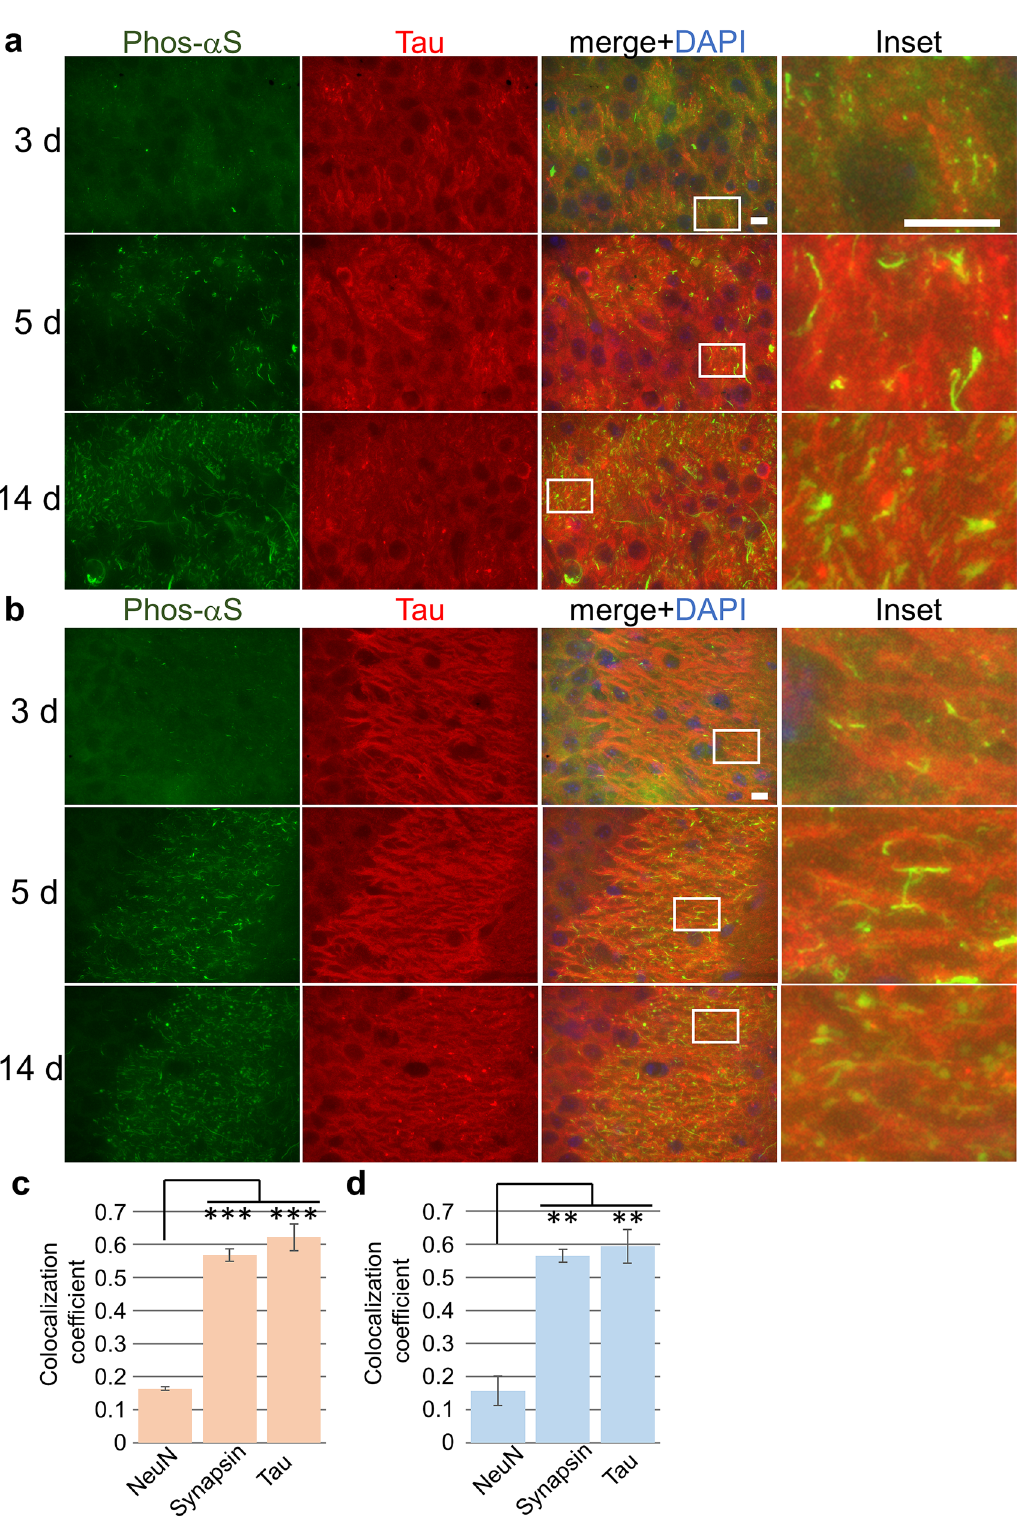
Figure 3. Seed-dependent phosphorylation of α-synuclein in axons of mouse neurons. ( a ) Appearance of phosphorylated α-synuclein (Phos-αS) in the CA3c region at 3 days (upper), 5 days (middle) or 14 days (lower) after the injection. Images show phosphorylated α-synuclein (green), tau (red), an axon marker, DAPI (blue) and the merged image in the CA3c region. Regions surrounded by white rectangles in merged images are magnified and shown in the rightmost panel of each lane. ( b ) Appearance of phosphorylated α-synuclein in the CA3a region at 3 days (upper), 5 days (middle) or 14 days (lower) after the injection. Images show phosphorylated α-synuclein (green), tau (red), DAPI (blue) and the merged image in the CA3a region. Regions surrounded by white rectangles in merged images are magnified and shown in the rightmost panel of each lane. ( c ) and ( d ) Quantification of the colocalization coefficient between phosphorylated α-synuclein and indicated markers at 5 days after the injection in the CA3c region ( c ) and the CA3a region ( d ) (mean ± S.E.M; n = 3). Statistical analysis was performed using one-way ANOVA and Tukey post hoc test. ** P < 0.01, *** P < 0.001. Scale bars, 10